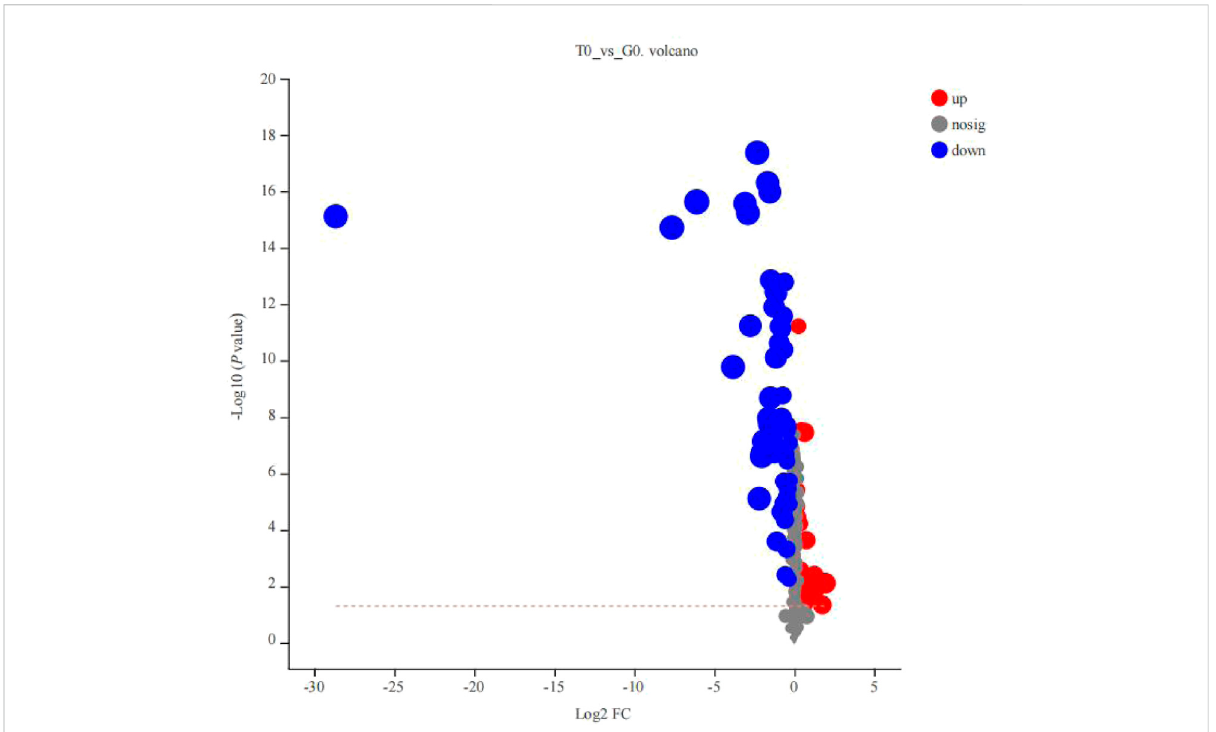
FIGURE 6 Volcano plot of the differentially expressed metabolites derived from the 2 groups (T0 vs. G0 groups). The X-axis indicated the differences in expressionlevelsbetweenthe2experimentalgroups.Y-axispresentsthestatisticalsigni fi canceofthedifferentialexpressionofthemetabolites.Red dots indicate the signi fi cantly upregulated metabolites, blue dots denote the signi fi cantly downregulated metabolites, and the gray dots indicate the insigni fi cantdifferencesinthemetabolites. p-value < 0.05(Forinterpretingthecolorschemeusedinthe fi gurelegends,thereaderscanreferto the online version of the research